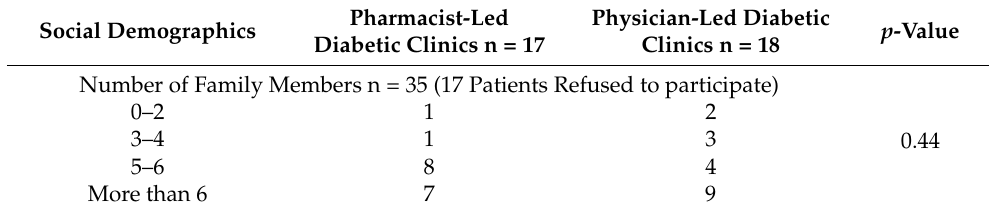
Table 2. Cont. Pharmacist-Led Physician-Led Diabetic Social Demographics Diabetic Clinics n = 17 Number of Family Members n = 35 (17 Patients Refused to participate)